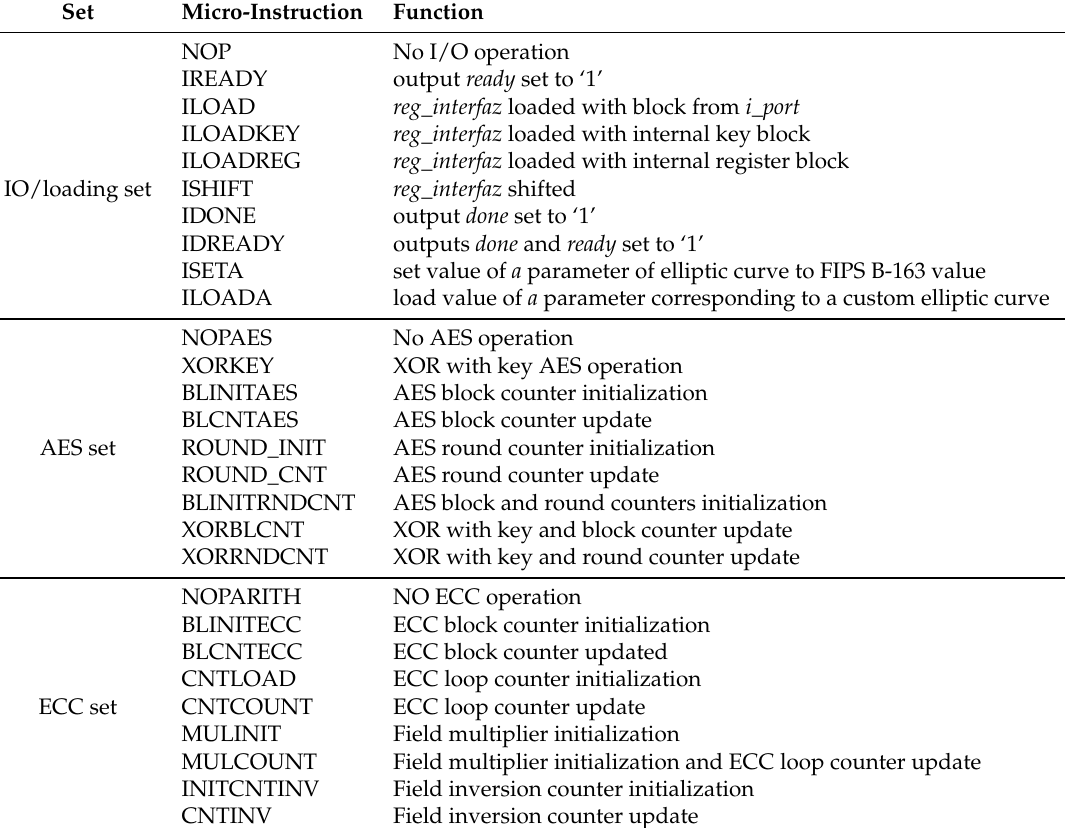
Table 3. ECC163AES128